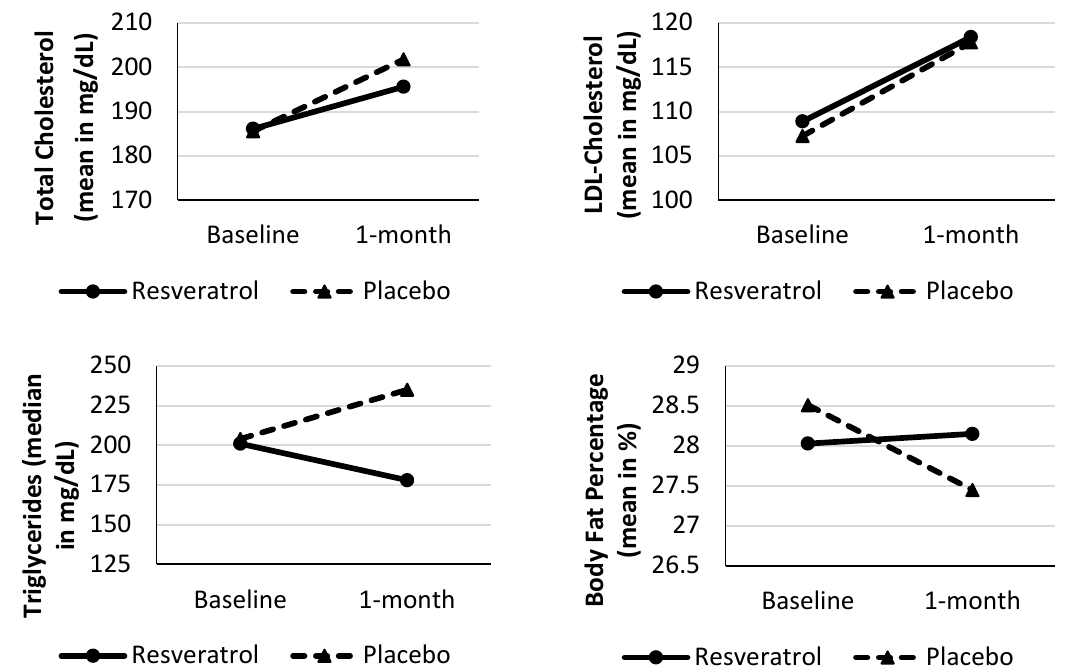
Figure 1. Characteristics of subjects with schizophrenia as baseline and after 1-month of resveratrol supplementation or placebo.